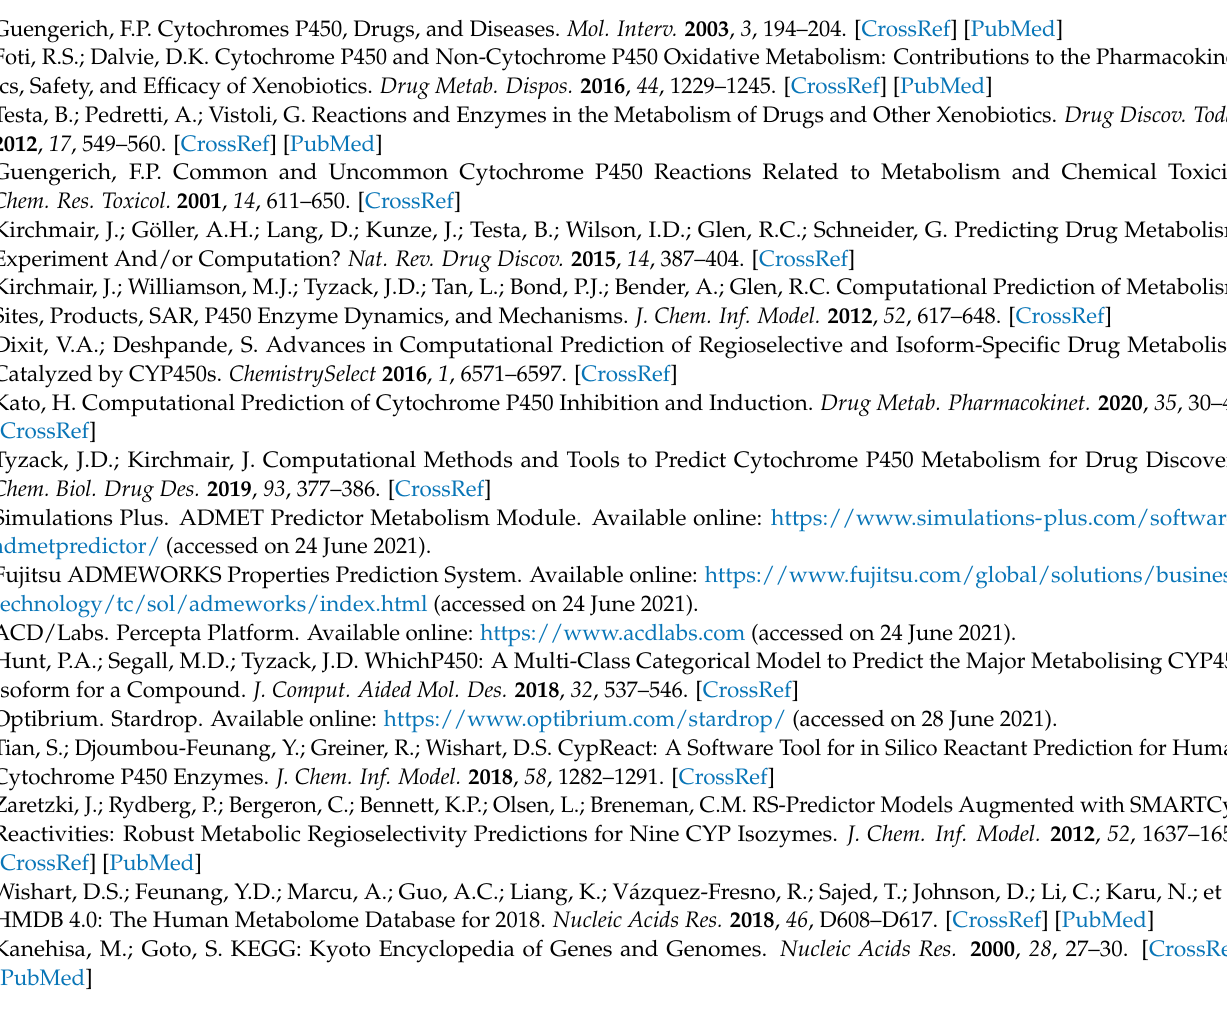
Table S2: RDKit 2D descriptors ranked by at least one RF classifier among the five most important features; all data used for model training and